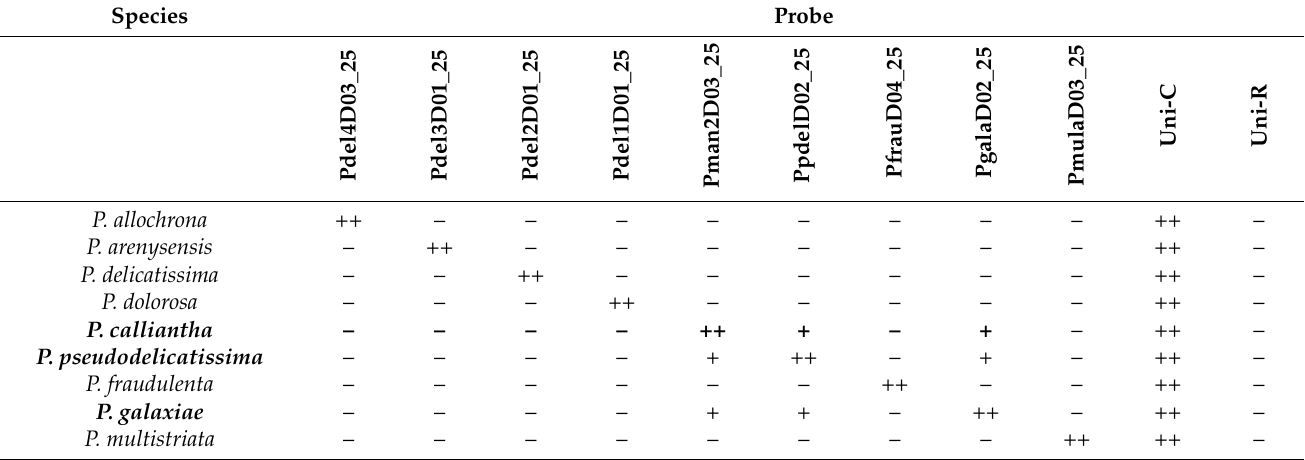
Table 5. Cross-hybridization trials. Cross-reactivity of the screened probes after WC-FISH optimiza- tion conditions. Probes that successfully hybridised were scored as positive “++” (highly visible) and “+” (weakly visible) under the epifluorescent microscope; probes that failed to detect a culture were scored as negative “–”. The species/probes still retaining cross-hybridization signals are in bold.